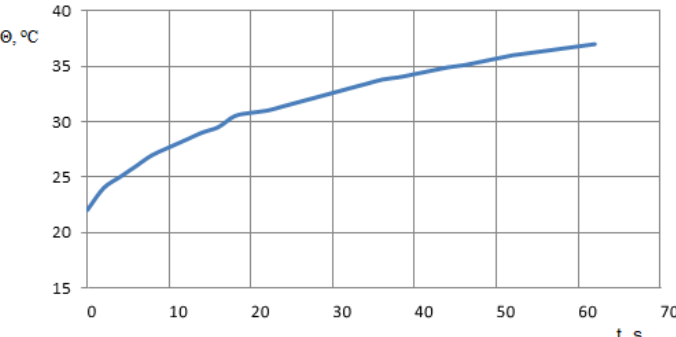
Figure 7. The thermal effect of the pulse electric heater core [own elaboration], graph that visually show the dependence of the corresponding functions on the arguments.